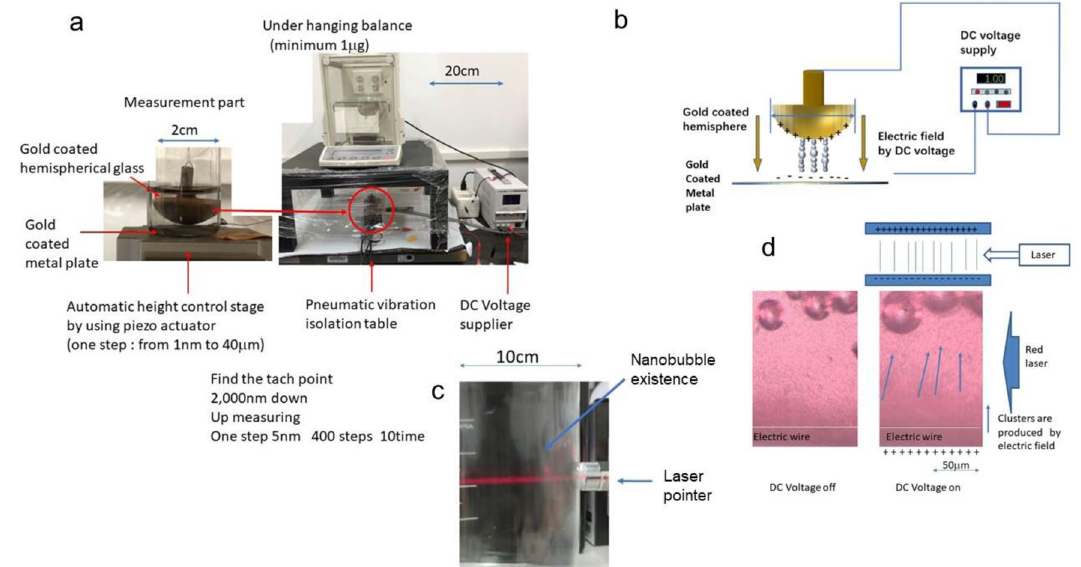
Figure 1. Experimental apparatus. ( a ) Photograph of the IFA apparatus used to measure nanobubbles. The left photograph shows the gold-coated flat plate and hemispherical glass plate in a nanobubble-containing fluid. The diameter of the hemispherical glass plate is 2 cm. The force between the hemispherical glass plate and the flat plate was measured by applying an electric field under a hanging electric balance (minimum 1 mg). ( b ) DC voltage supplier (right photo) applied an electric field between the flat plate and the hemispherical plate. The distance between the flat plate and the hemispherical plate is controlled from each 1–40 nm step using a piezoelectric stage fixed under the flat plate. The nanobubble shape is considered spherical both in the absence and presence of dielectric polarization. ( c ) The red laser pointer shows a distinct line indicating the existence of nanobubbles due to the Tyndall effect. ( d ) Existing nanobubbles formed clusters in the direction of the electric field under the application of a red laser (635–690 nm) (Here, the electric field is applied to the containing nanobubbles liquid set between two cylindrical